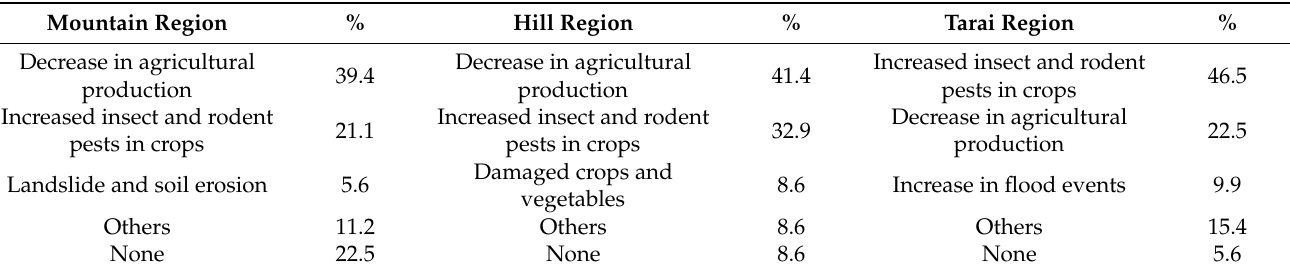
Table 6. Noticed adverse impacts of climate